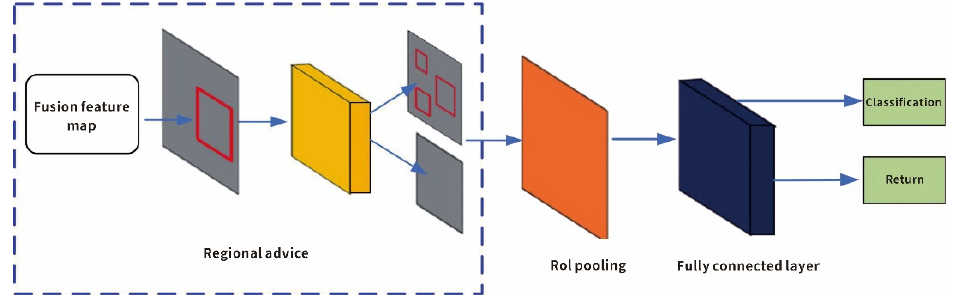
Figure 10. Feature fusion area suggestion module.